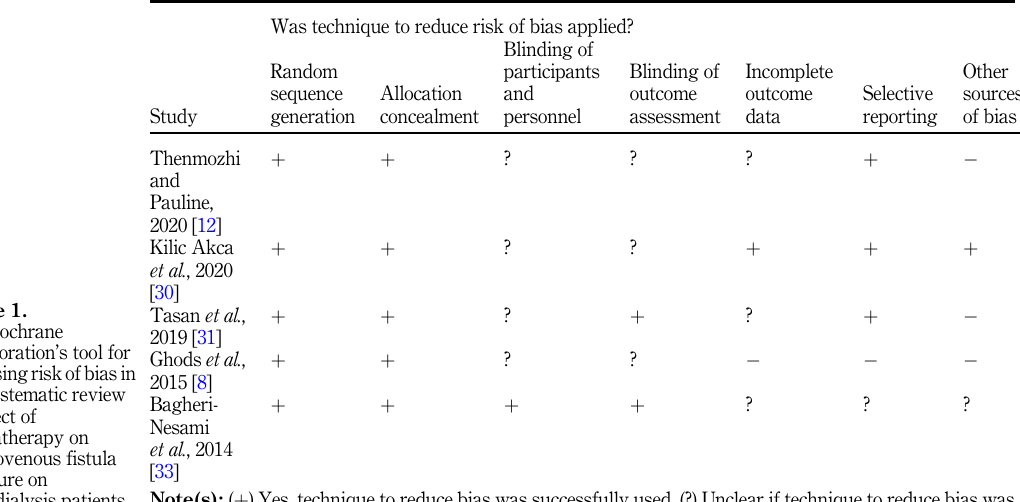
collaboration ’ s tool for assessingriskofbiasin the systematic review of effect of aromatherapy on arteriovenous fistula puncture on hemodialysis